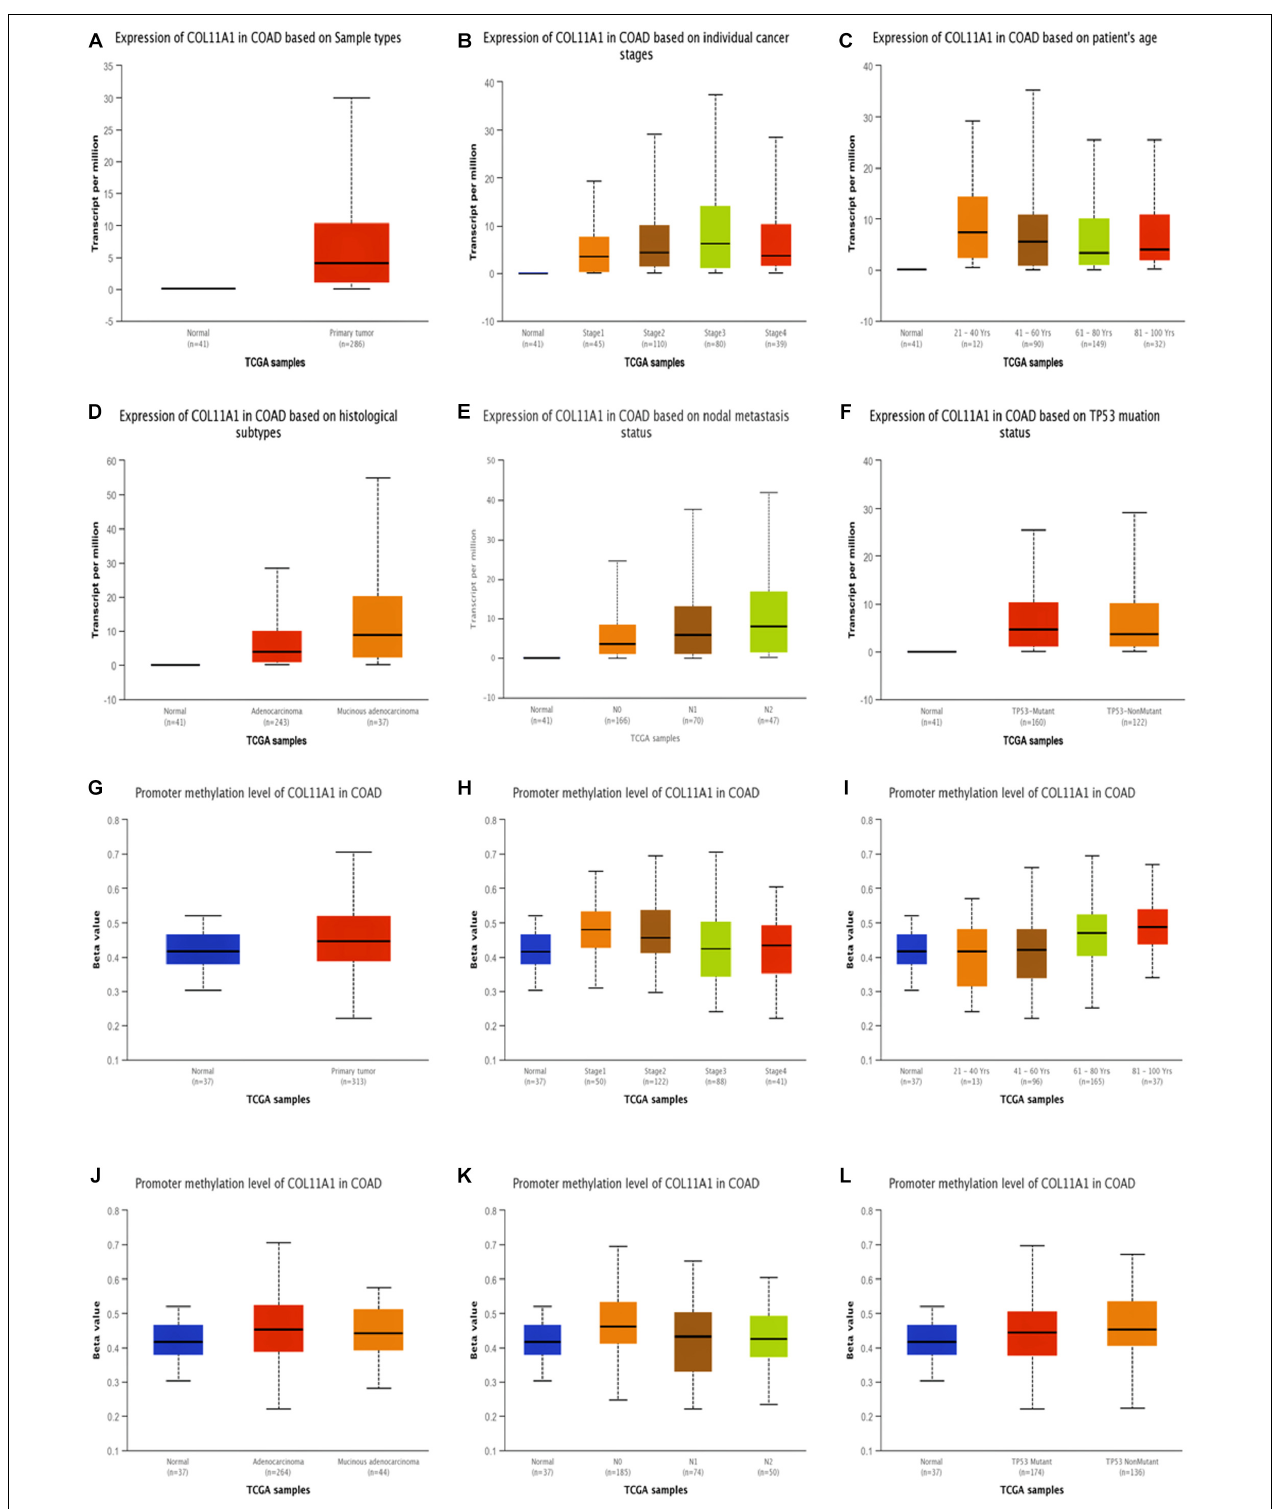
FIGURE 2 | Expression and promoter methylation of the COL11A1 gene in colon adenocarcinoma for different clinicopathological parameters. (A–F) Box-plot showing relative expression of COL11A1 mRNA in panel (A) . cancer tissues and normal tissues, (B) individual cancer stage, (C) patient’s age, (D) histological subtypes, (E) nodal metastasis status, (F) TP53 mutation status. (G–L) Box-plot showing promoter methylation of COL11A1 mRNA in, (G) cancer tissues and normal tissues, (H) individual cancer stage, (I) patient’s age, (J) histological subtypes, (K) nodal metastasis status, (L) TP53 mutation status.